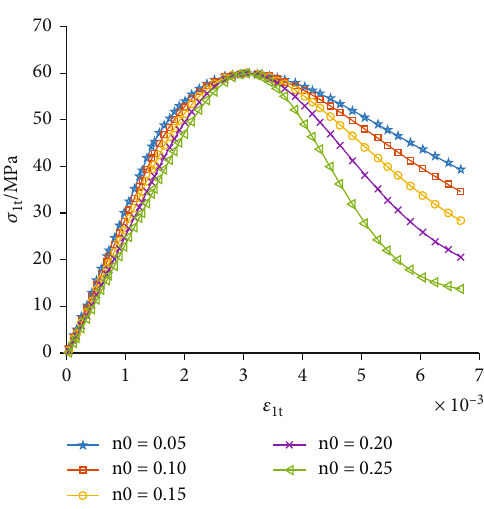
Figure 5: Initial porosity sensitivity